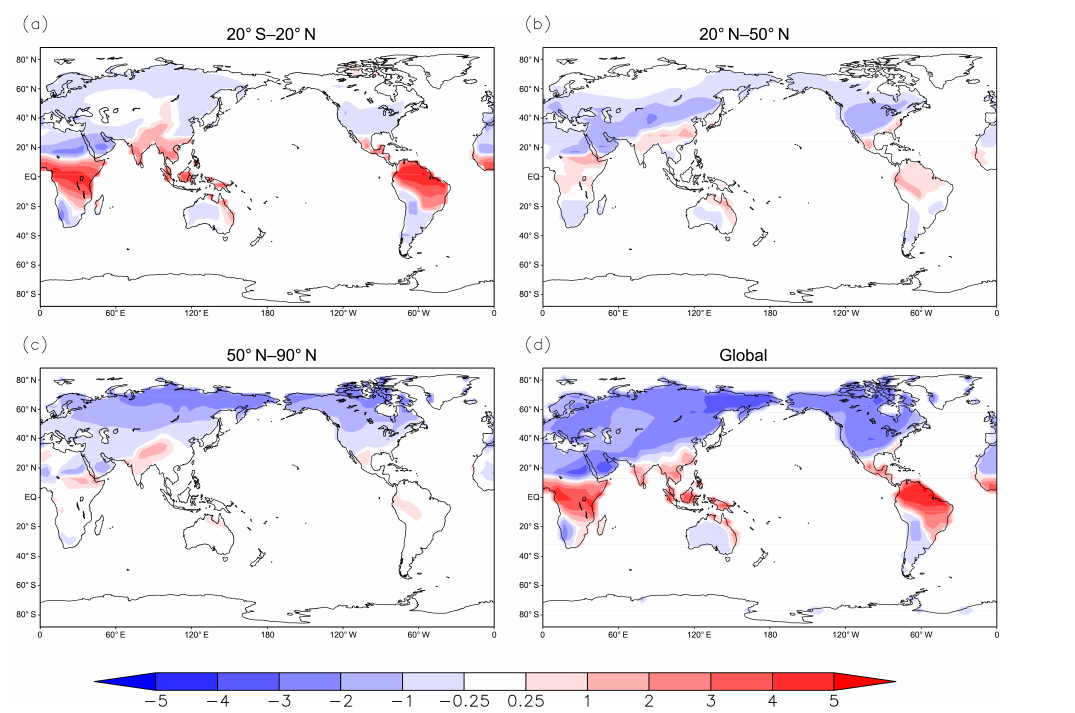
Figure 1. Ground temperature change for (a) tropical (20 ◦ S–20 ◦ N), (b) northern temperate (20–50 ◦ N), (c) boreal (50–90 ◦ N), and (d) global (90 ◦ S–90 ◦ N) deforestation (unit: K). Table 2. Changes in key climate variables from regional and global deforestation experiments. “ (cid:49) ” denotes change relative to the control experiment. The value for each climate variable is the area-weighted change over deforested areas for different latitude zones. The symbol “ ↑ ” denotes upward and “ ↓ ” denotes downward. Units are watts per square meter for energy flux, kelvin for temperature, millimeters per day for precipitation; albedo is